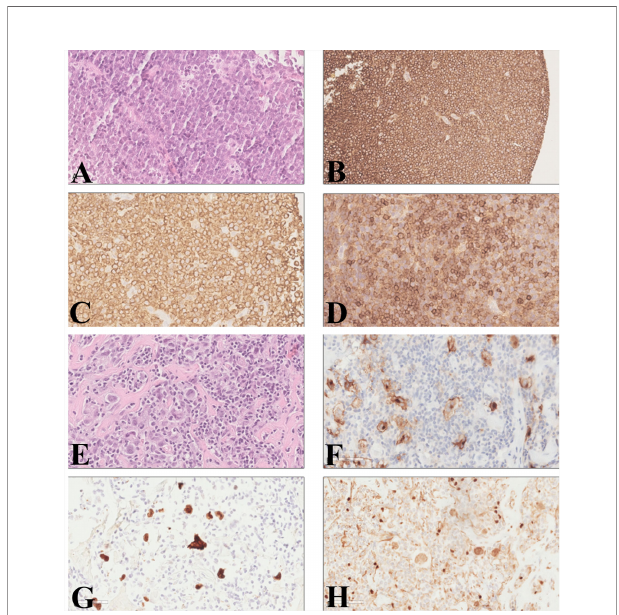
FIGURE 1 | Diffuse large B-cell lymphoma and classical Hodgkin ’ s lymphoma diagnosis on lymph node biopsy. Large lymphoid cells with basophil cytoplasm, ovalar nuclei, and one or more nucleoli; small lymphocytes with a round nucleus were visible among the more numerous large cells ( A , hematoxylin and eosin). The large cells were positive for CD20 (B) and BCL2 (C) . CD5 was strongly positive in the small cells, while the large cells were partially and weakly positive (D) . Large pleomorphic cells, with one or two ovalar nuclei and macro-nucleoli in a background of small lymphocytes and granulocytes with fi brosis ( E , hematoxylin and eosin). The large cells were positive for CD30 (F) and PAX5 (H) . Immunohistochemical staining for EBV- encoded RNA (EBER) was positive (G) . ( A , C , D – H : original magni fi cation ×40; B : original magni fi cations